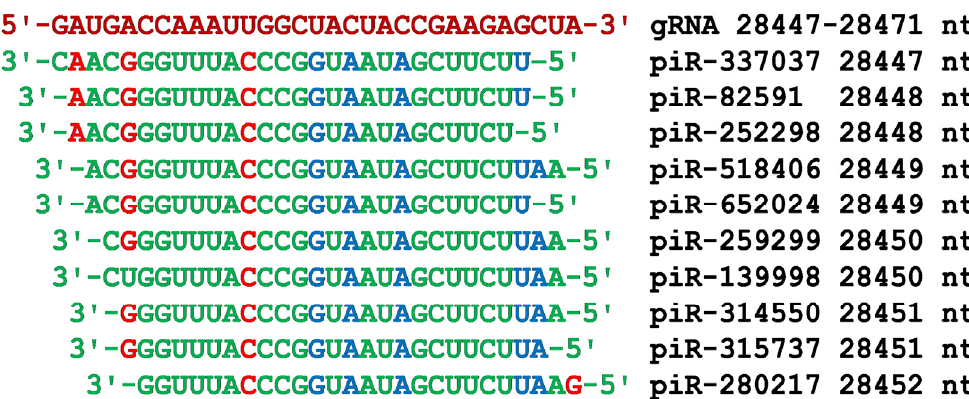
Figure 12. Nucleotide sequences of the 10 piRNA BSs cluster in the CDS of gRNA from 28,447 nt to 28,471 nt and the nucleotide sequences of piRNAs. Note: The piRNA nucleotides that form canonical pairs with gRNA are highlighted in green and non-canonical pairs are highlighted in blue. The piRNA nucleotides that do not interact with gRNA are highlighted in red. The names of the piRNAs are followed by the beginning of their BSs.